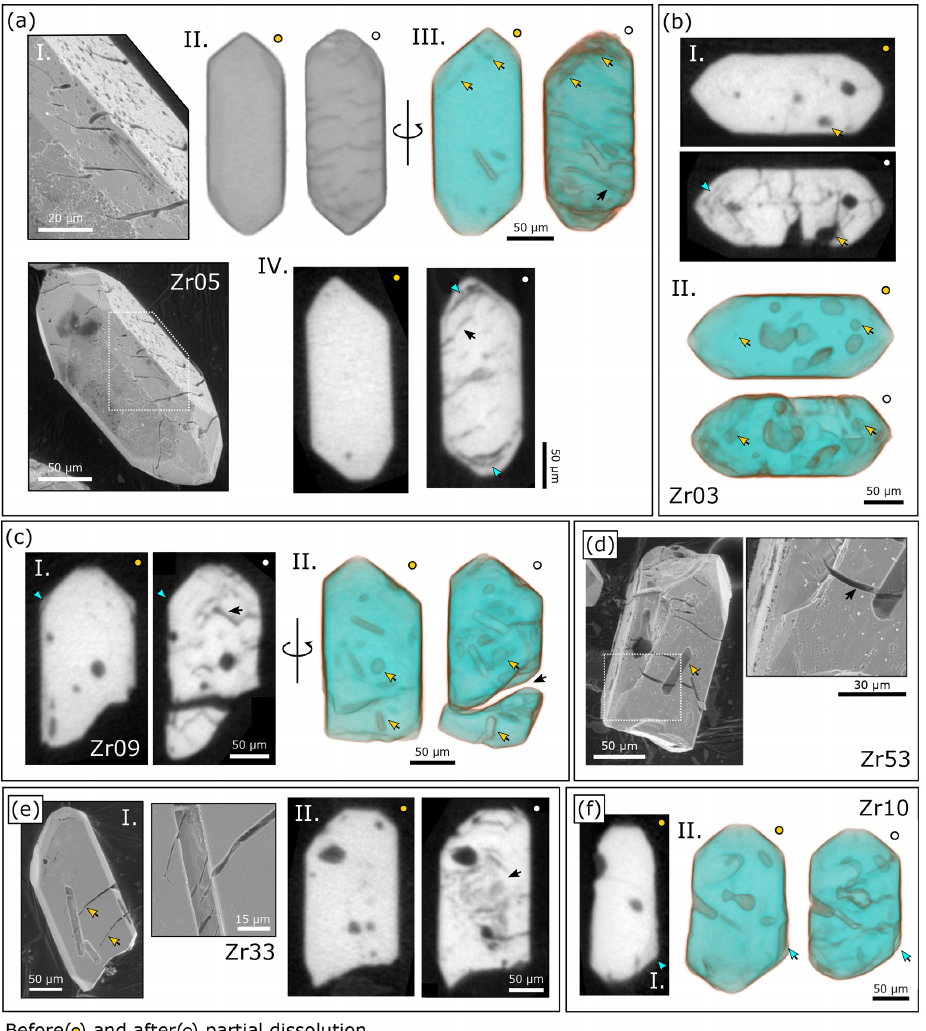
Figure 12. SE and µCT images of SAM-47 grains pre- and post-chemical abrasion at 180 ◦ C for 4h. (a) Subpanel (I) shows SE images of Zr05, showing deep grooves on the grain’s surface and a sponge-like etch texture. (II) Opaque 3D rendering of µCT data showing that these surface fractures are only apparent after partial dissolution. (III) Semi-transparent 3D rendering of µCT data with yellow arrows marking inclusions removed by partial dissolution. (IV) 2D µCT image slices highlighting an example of an acid path into the grain interior (black arrow) and the removal of concentric zones (teal arrow). (b) Subpanel (I) shows 2D µCT image slices showing the removal of fine-scale concentric zones (teal arrow) and a mineral inclusion (yellow arrows) in Zr03. (II) Semi-transparent 3D rendering of µCT data with yellow arrows depicting the removal of more mineral inclusions. (c) Subpanel (I) shows 2D µCT image slices of Zr09, showing the removal of a low- density rim (teal arrow) and an acid path into the grain interior (black arrow). (II) Semi-transparent 3D rendering of µCT data highlighting the removal of inclusions (yellow arrows) and the formation of a large fracture (black arrow). (d) SE images of Zr53 showing crystal-shaped voids interpreted as dissolved surface-reaching inclusions (yellow arrow) and the fractures that cross-cut these voids (black arrow). (e) SE images of Zr33, again showing fractures cross-cutting inclusions removed by partial dissolution (yellow arrows) and a smooth grain surface. (II) 2D µCT image slices showing a convolute pattern of material dissolved from the crystal core. (f) Subpanel (I) shows 2D µCT image slices highlighting a low-density rim on Zr10. (II) Semi-transparent 3D rendering of µCT data showing the removal of this rim.